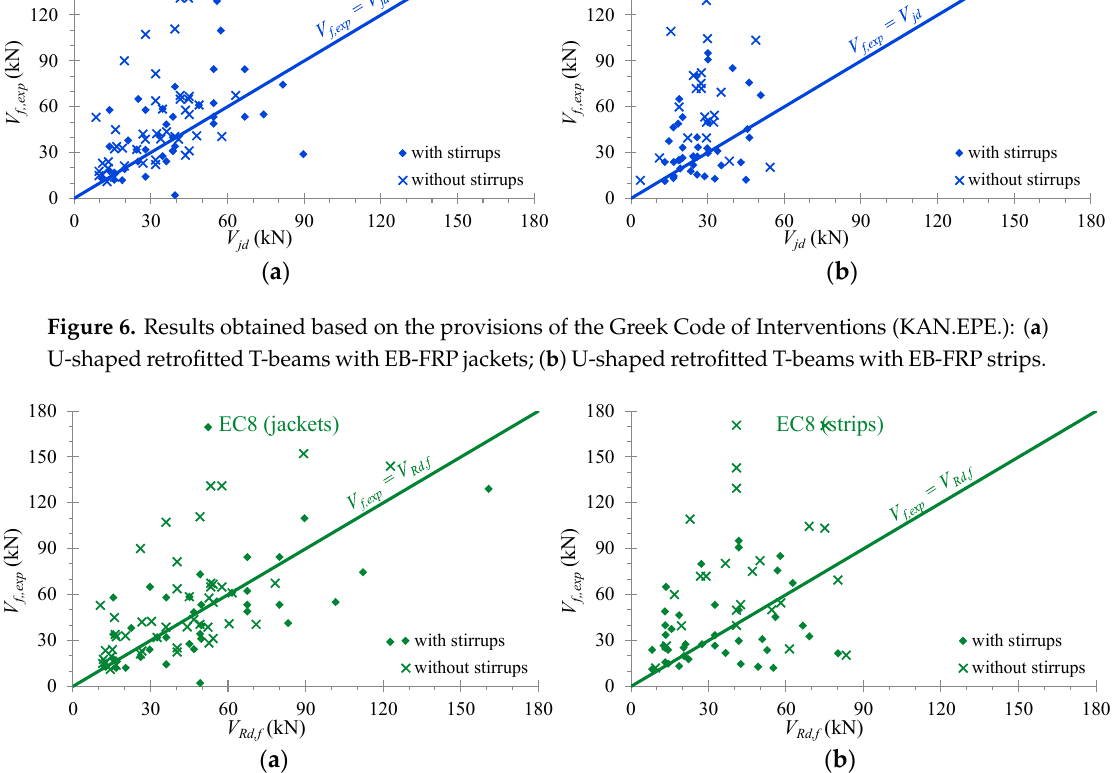
Figure 7. Results obtained based on the provisions of the Eurocode 8 part 3: ( a ) U-shaped retrofitted T-beams with EB-FRP jackets; ( b ) U-shaped retrofitted T-beams with EB-FRP strips.